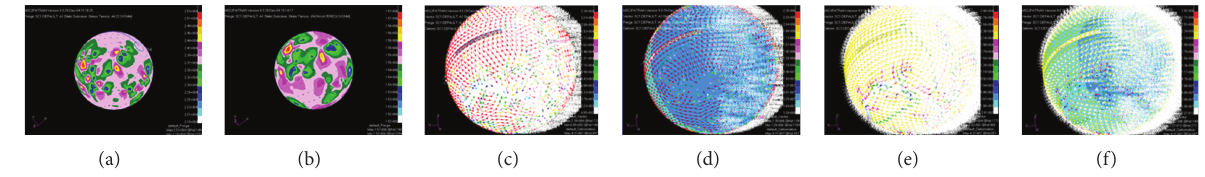
Figure 5: The stress and strain distribution ignoring viscoelasticity of human skull and dura mater. (a) Stress distribution, (b) strain distribution, (c) the maximal stress vector distribution, (d) the maximal strain vector distribution, (e) stress vector distribution, and (f) strain vector distribution.